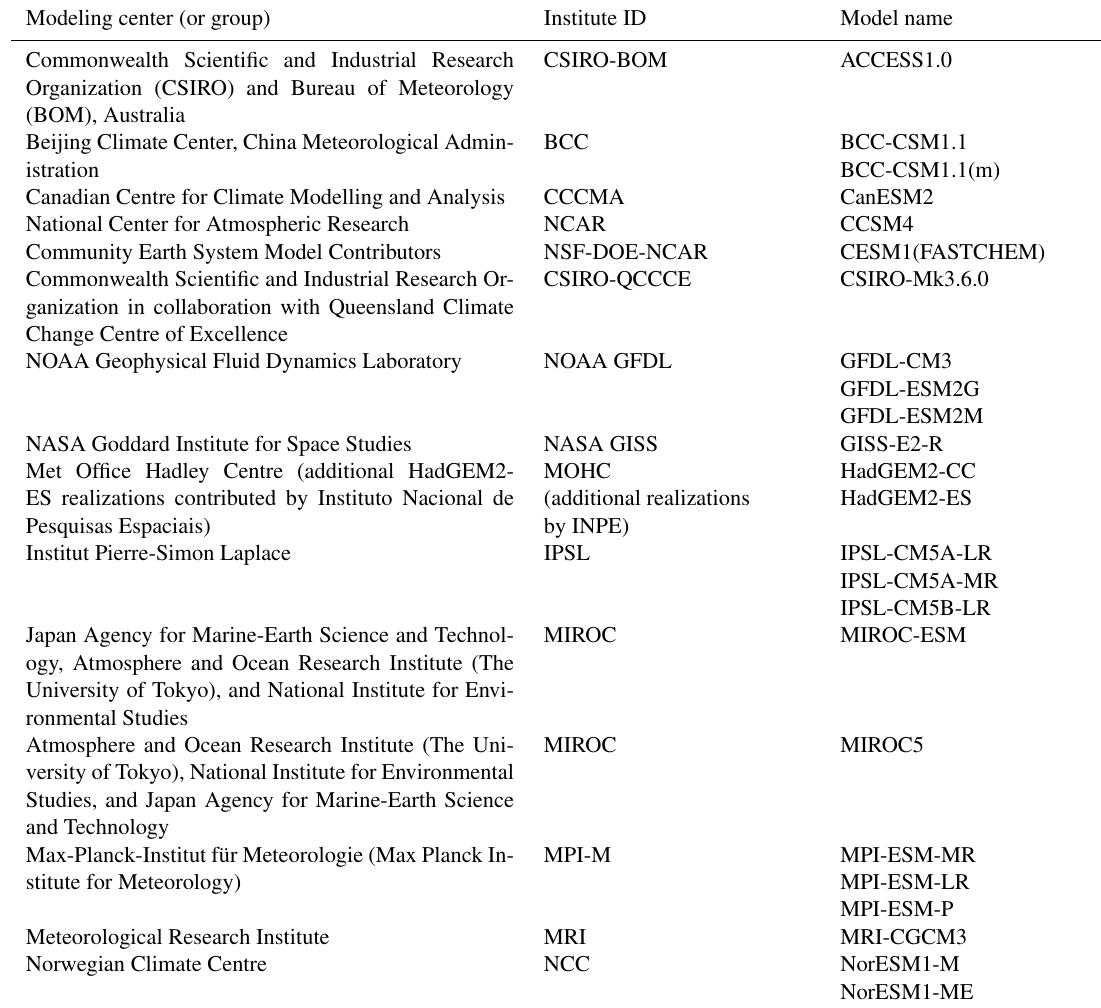
Table 1. List of CMIP5 models and group names. Modeling center (or